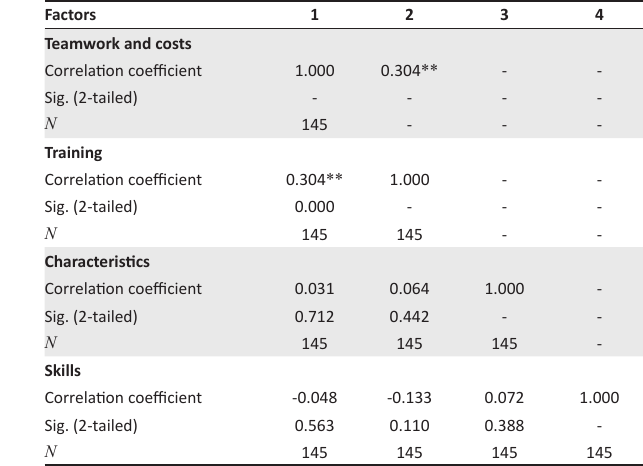
TABLE 9: Correlation between the four factors of the attitudes towards people with disabilities